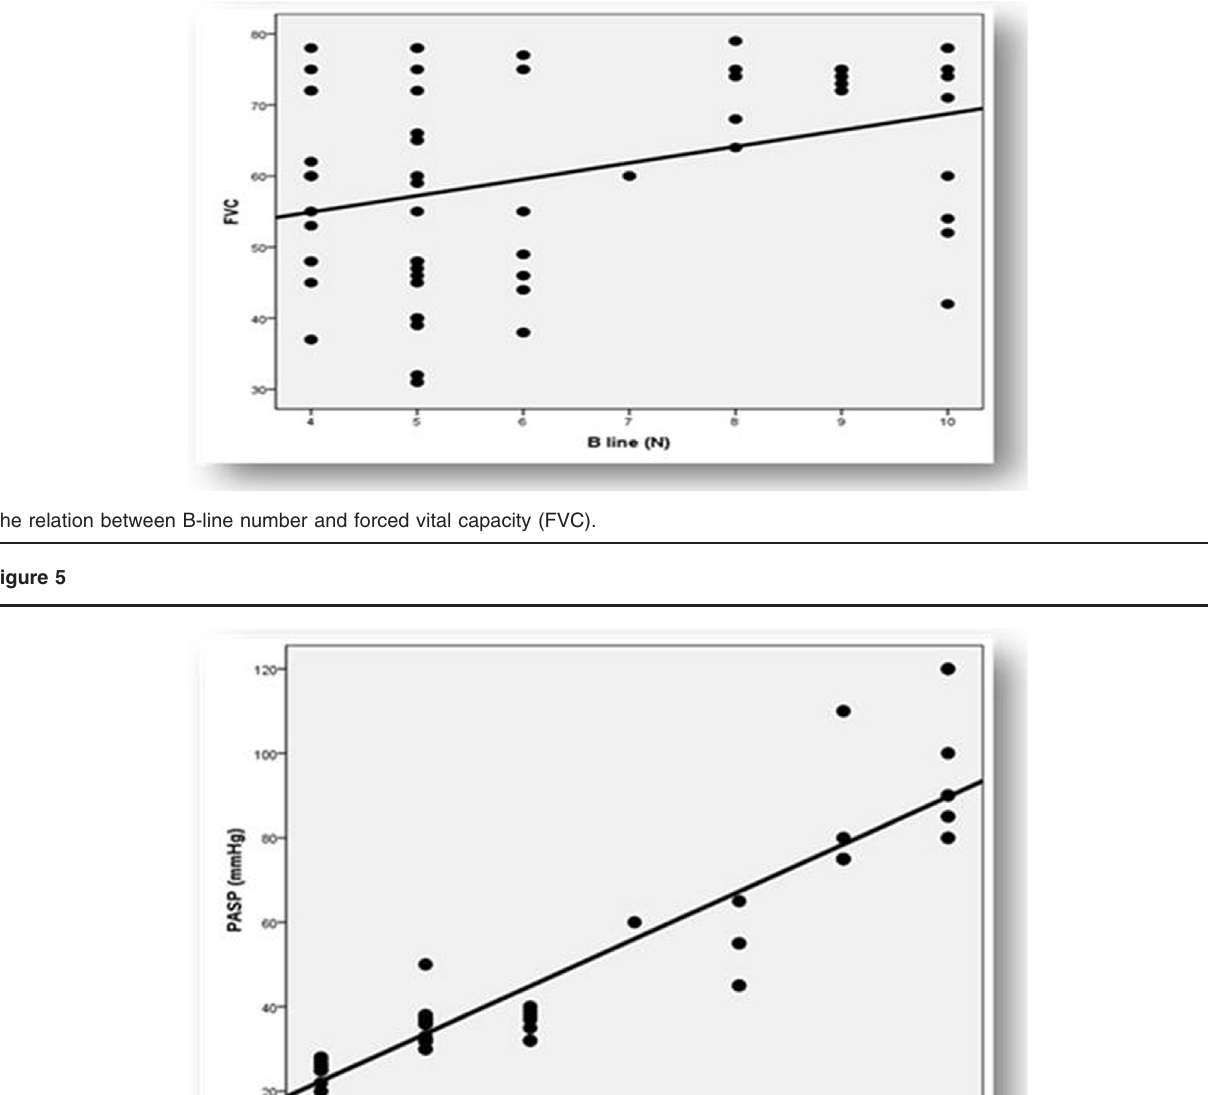
The mean ± SD of B-line number was 6.3 ± 2.1. The B-